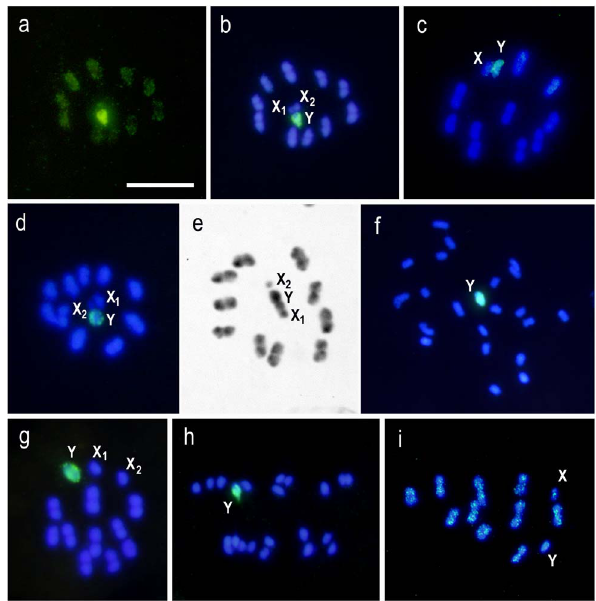
Figure 3. Inter-specific GISH of triatomine species using three genomic DNA (gDNA) probes: Triatoma delpontei (TD) (male or female) and Triatoma infestans (TI) (Andean group). Bar 5 5 m m. (a–b) TD gDNA on Triatoma dimidiata chromosomes. Metaphase II (2n 5 20A + X 1 X 2 Y). (a) FITC (b) Merged. All chromatin present dispersal hybridization signals but only the Y chromosome exhibits a very strong labeled. (c) TI (Andean group) gDNA on T. carrioni chromosomes. Metaphase I (2n 5 20A + XY). Strong hybridization signals are restricted to the heterochromatic Y chromosome. (d) TD gDNA on T. protracta chromosomes. Metaphase II (2n 5 20A + X 1 X 2 Y). Only the Y chromosome presents strong hybridization signal in spite of the autosomal C-bands in all autosomal pairs and in one X chromosome. (e) T. protracta . C-banding. Metaphase II. All autosomal pairs, the Y chromosome and one X chromosome present C-blocks in one or both chromosomal ends. (f) TD gDNA on Dipetalogaster maxima chromosomes. Spermatogonial mitotic prometaphase with 22 chromosomes (2n 5 20A + XY). Only the Y chromosome presents intense hybridization signal. (g) TI (Andean group) gDNA on Eratyrus mucronatus chromosomes. Metaphase I (2n 5 20A + X 1 X 2 Y). Only the Y chromosome presents hybridization signal. (h) TI (Andean group) gDNA on Panstrongylus geniculatus chromosomes. Anaphase II (2n 5 20A + X 1 X 2 Y) showing a post-reductional sex chromosomes segregation. Only the Y chromosome has strong hybridization signals. (i) TI (Andean group) gDNA on Rhodnius prolixus chromosomes. Metaphase I (2n 5 20A + XY). The hybridization signals are scattered throughout all chromosomes. No chromosomal region was observed with intense labeled signals, including the heterochromatic Y